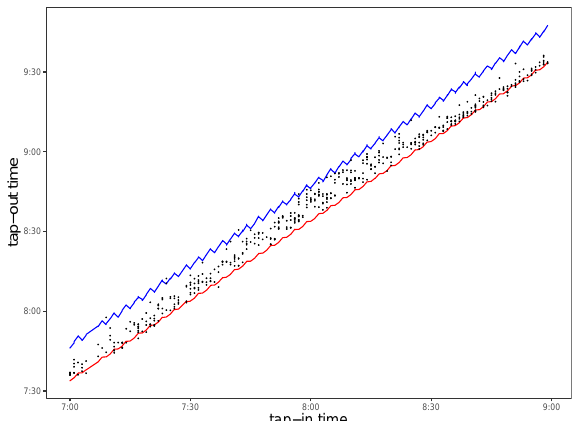
Figure 14. Prediction intervals of the tap-out times. The red and blue lines denote the lower and upper limits of the intervals, respectively. The black dots denote the test